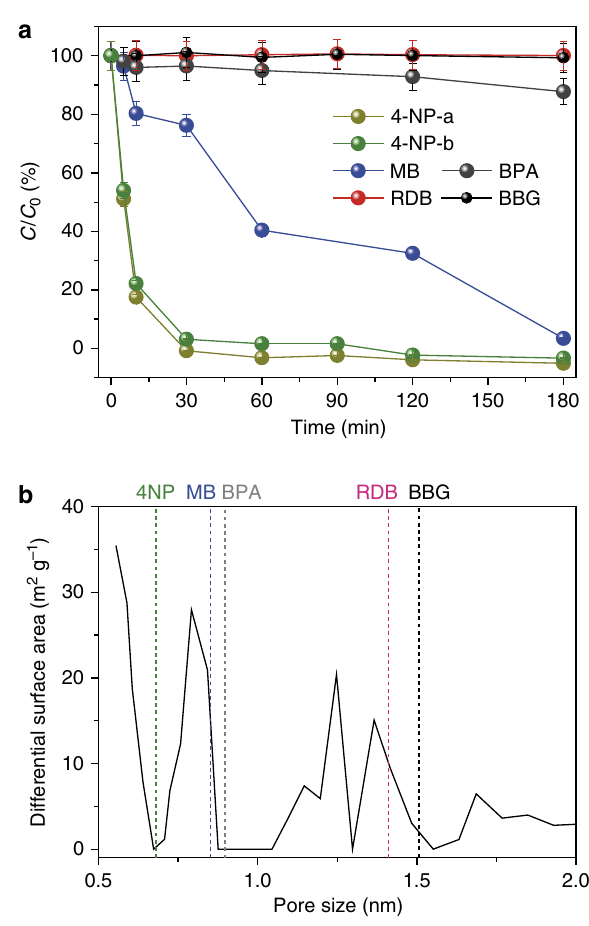
Figure 4 | Size selective separation of water-soluble substrates by COP-99. ( a ) Change in dye concentrations over time after being treated with COP-99 in terms of absorbance relative to initial absorbance ( C / C 0 ). Initial concentration ( C 0 ) of all the dyes was adjusted to be 50 m M. 4-NP was tested both in acidic (4-NP-a, pH ¼ 4) and basic (4-NP-b, pH ¼ 9) conditions. Error bars reflect s.d. from duplicates. ( b ) Surface area distribution with respect to pore size, and its relation towards minimum van der Waals size of dye